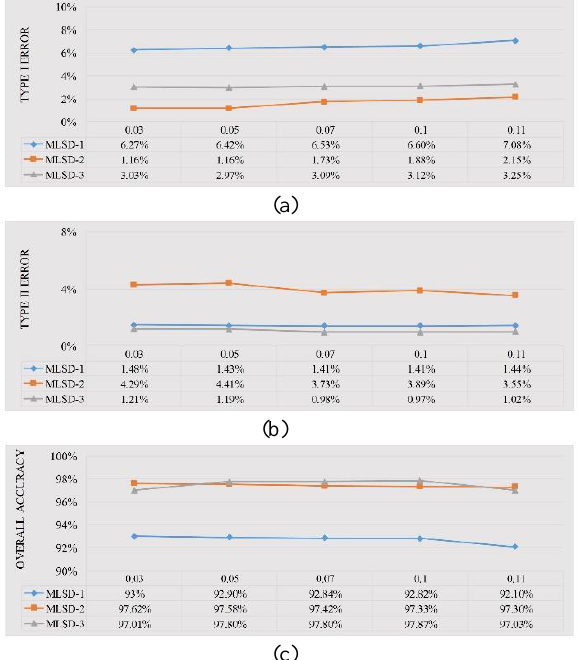
Fig.5 Sensitivity tests with the size of 3-D voxel ( Γ v ): (a) Type I error, (b) Type II error, and (c) Overall accuracy